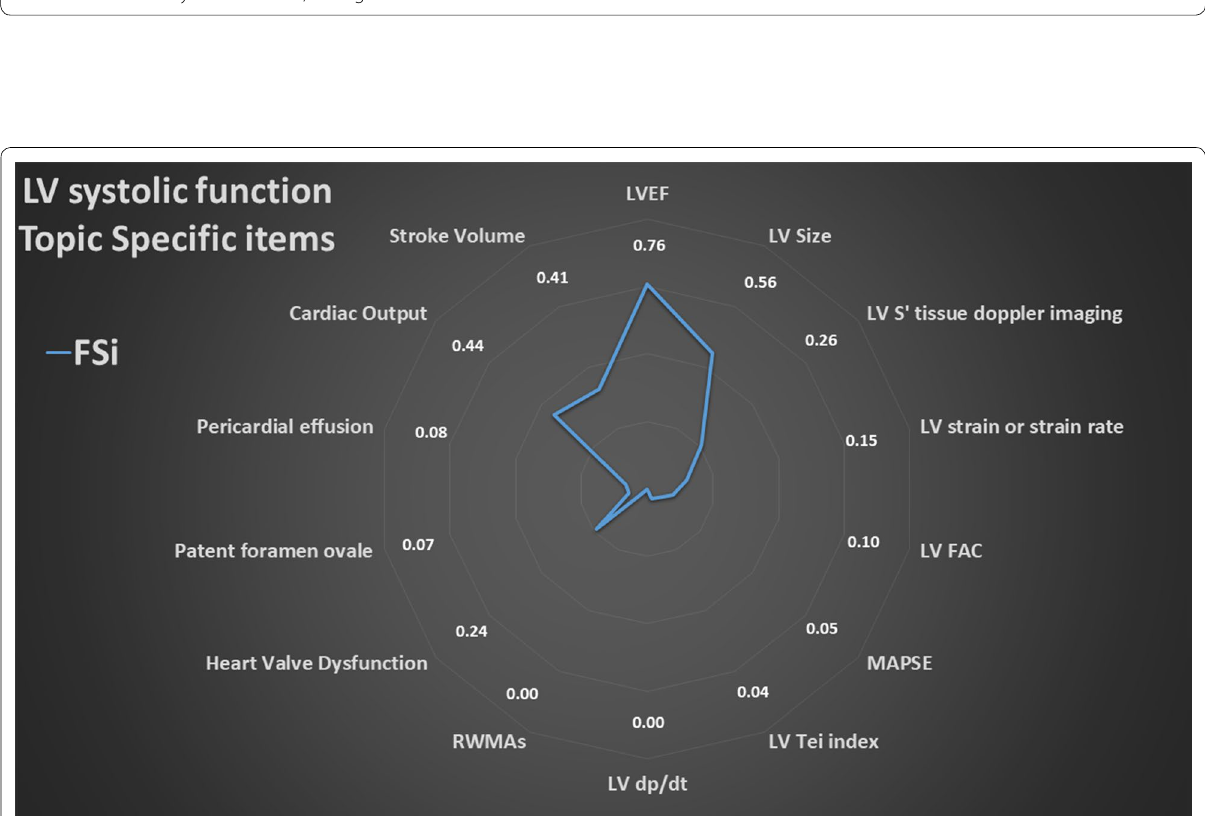
Fig. 3 Radar plot of the fraction of studies reporting an item (FSi) in the left ventricular (LV) systolic function topic. HFrEF history of heart failure with reduced ejection fraction, LVEF LV ejection fraction, LVFAC LV fractional area change, MAPSE mitral annulus plan systolic excursion, RWMAs regional wall motion abnormalities, S ʹ maximal systolic velocity by tissue Doppler imaging at the mitral annulus. As example, an FSi score of 0.76 for LVEF means that 76% of studies on LV systolic function reported